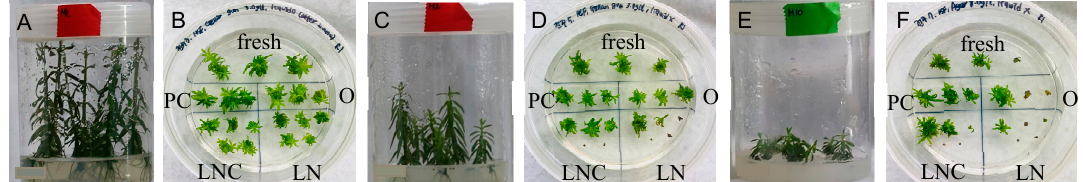
Figure 5. In vitro subcultured P. yatabeana plantlets for five weeks in the last subculture cycle before cryopreservation (C-0 cycle, ( A , C , E )) and regrowth of subsequently cryopreserved shoot tips ( B , D , F ) after four weeks in regrowth medium of RM1 (ammonium-free MS)-RM2-MSF. Subculture condition for ( A , B ) was Gell+Liquid-O; C and D, Gell + Liquid-X; ( E , F ), Agar + Liquid-X. (for ( B , D , F )) fresh, fresh control shoot tips; PC, preculture with 10% sucrose for 31 h; OP, PC and osmoprotected with C4–35% for 40 min; LNC, PC-OP and cryoprotected (CP) with A3–80% ice for 60 min, but not cryopreserved; LN, PC-OP-CP and cryopreserved (LN). OP, LNC, and LN shoot tips were unloaded with 30% sucrose solution for 40 min before